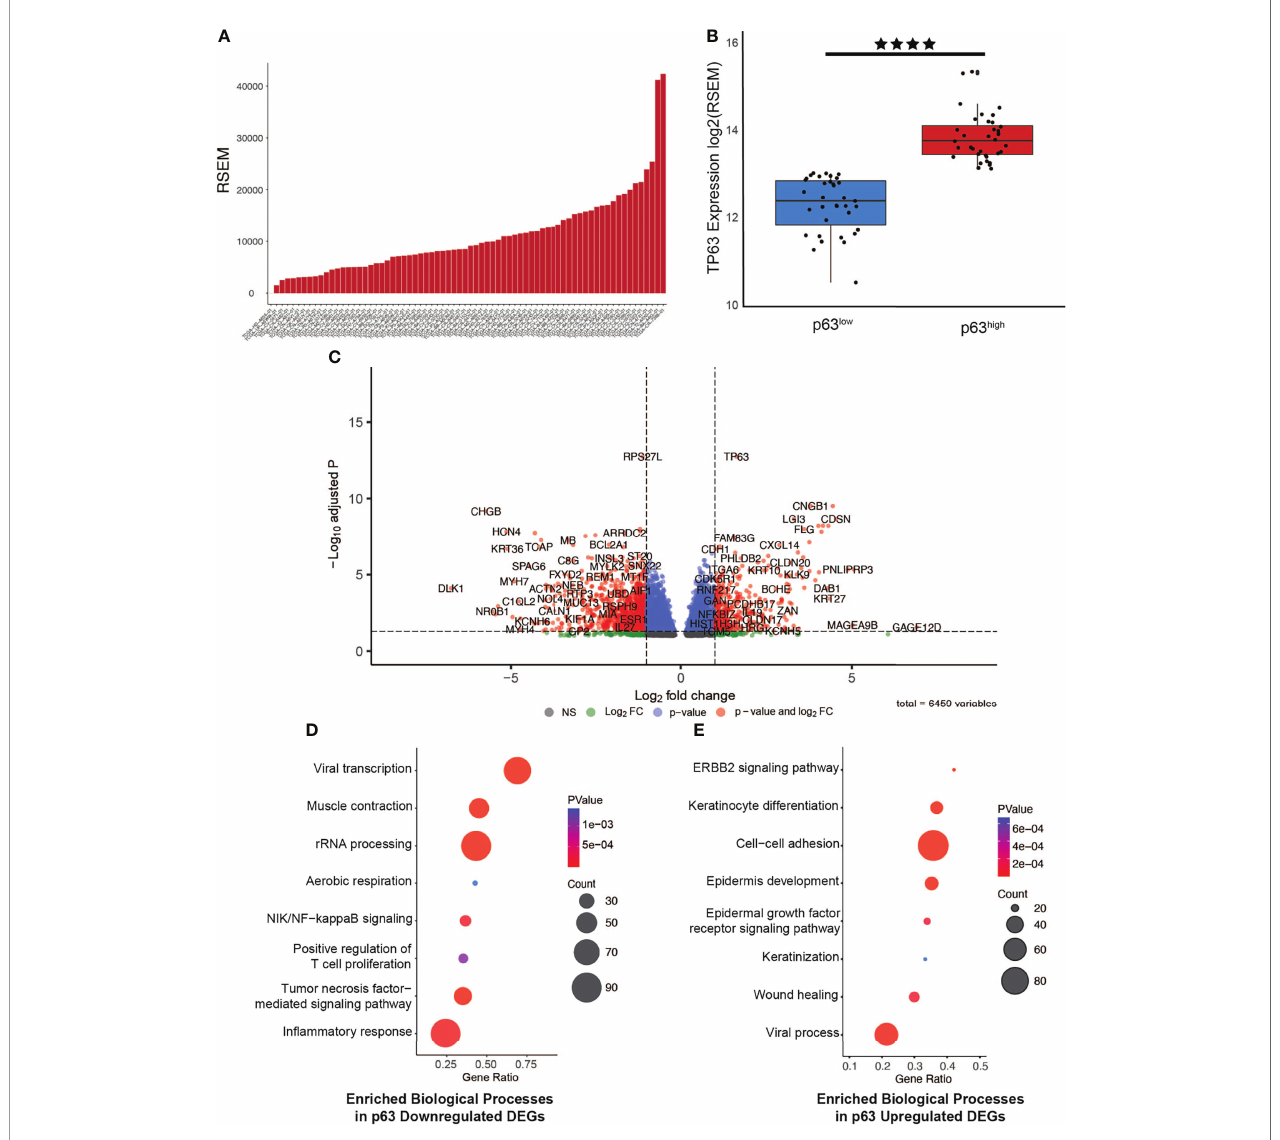
FIGURE 1 | Generation of a p63-driven gene signature in HPV+ HNSCC TCGA tumors. (A) Bar chart of p63 expression across tumors in the TCGA HPV+ HNSCC dataset. (B) Boxplots displaying the signi fi cant difference in expression of TP63 between the groups ( p value = 2.472e-6). Tumors were segregated into p63 low and p63 high groups on the basis of median p63 expression. (C) Volcano plot of identi fi ed DEGs between p63 low and p63 high samples. TP63 is shown as one of the most signi fi cant DEGs. (D) Gene Ontology (GO) based biological pathway analysis of DEGs whose expression was downregulated according to p63 expression. (E) GO biological pathway analysis of DEGs whose expression was upregulated according to p63 expression. **** symbol means a p -value of ≤